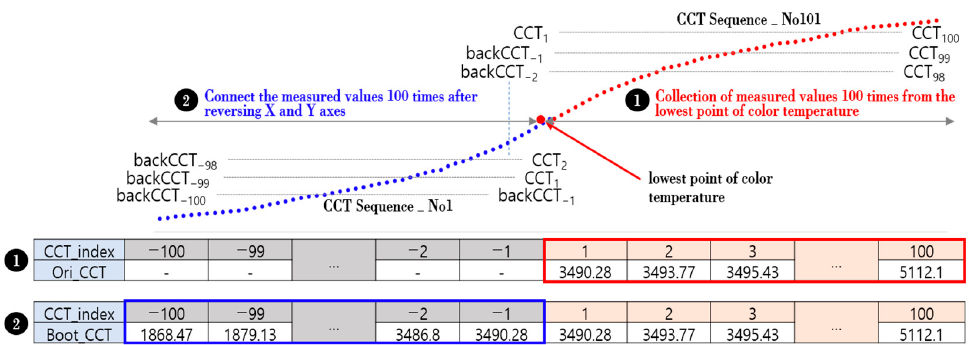
Figure 5. Boot data set creation process .